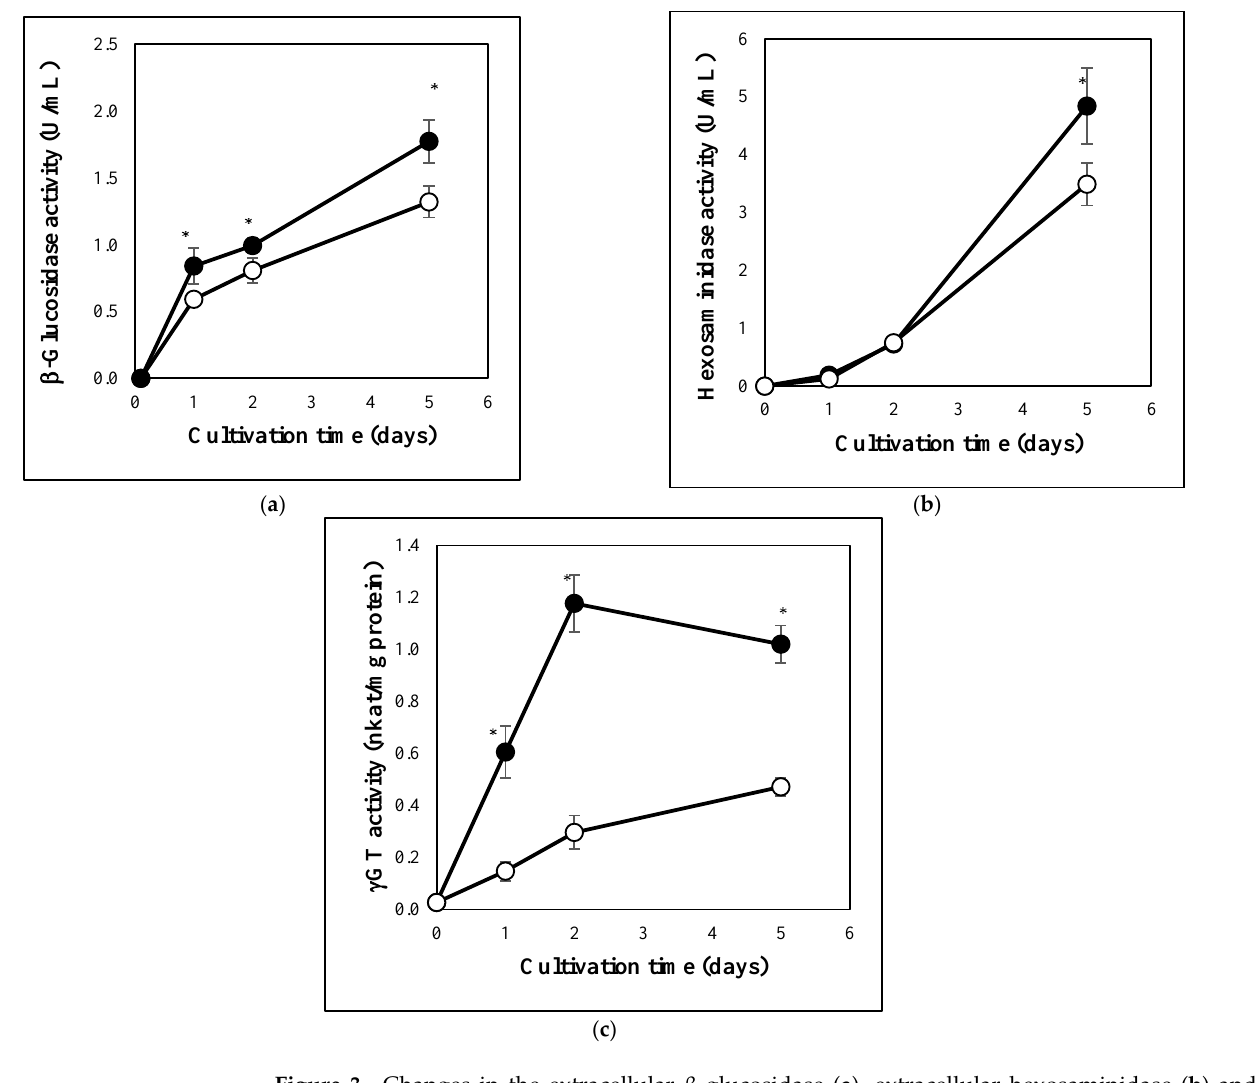
Figure 3. Changes in the extracellular β -glucosidase ( a ), extracellular hexosaminidase ( b ) and intracellular γ GT ( c ) activities of carbon limited and carbon-starved A. fumigatus cultures. A. fumigatus Af293 mycelia from exponentially growing phase cultures were resuspended in carbon-source-free minimal mediums either supplemented (carbon-limited cultures; ○ ) or not (carbon-starved cultures; ● ) with 4 g/L casein peptone. Mean ± SD calculated from three parallel experiments are presented. One unit (U) was defined as an amount of enzyme that can cause a one-unit change in the absorb- ance over 1 h under the conditions described by the method used. * — Significant differences be- tween the mean values of the carbon-starved and carbon-limited cultures at the marked time point according to the Student’s t -test ( p < 0.05).